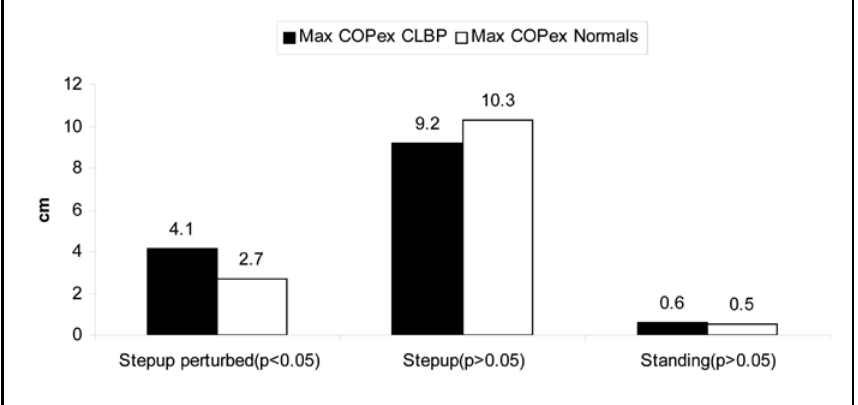
Figure 3: Maximum coP excursions during step-up with perturbation, step-up and quiet standing task in clBP and healthy participants with inde- pendent ‘t’ test